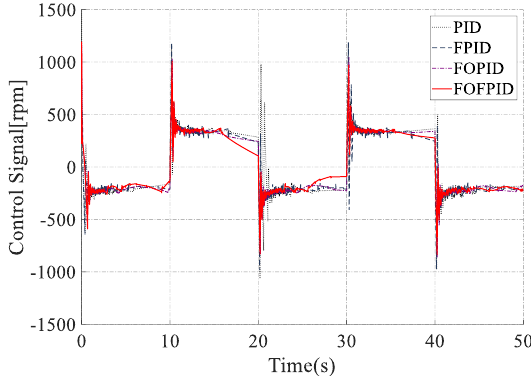
Figure 14. Control signal of conventional PID (CPID), fuzzy PID (FPID), FOPID and proposed FOFPID.